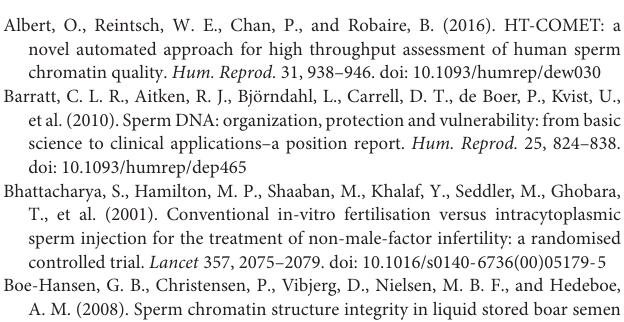
Supplementary Figure 1 | Workflow for the optimized use of the Comet assay in pig sperm. Supplementary Figure 2 | Diagram of hydrogen peroxide and DNAse I treatments conducted in this